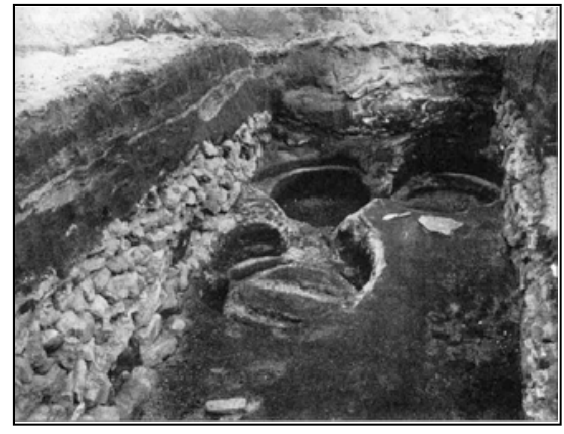
Figure 10. Whey barrel imprints in the storage room of the farm Stong (from Agustsson 1989 [46]).